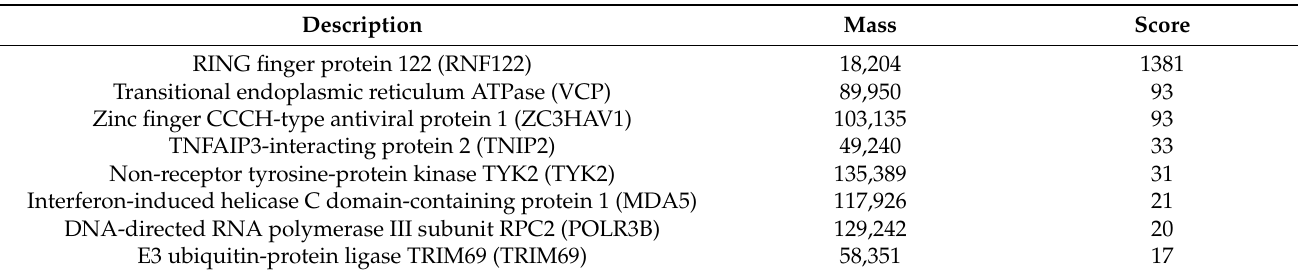
Table 6. The type I interferon signaling pathway associated proteins in the RNF122 interaction proteins were identified by mass